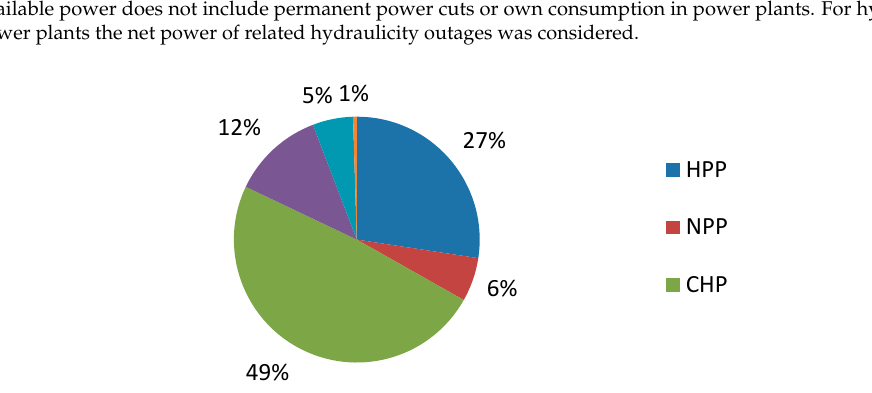
Figure 2. The installed power in various sources in Romania.